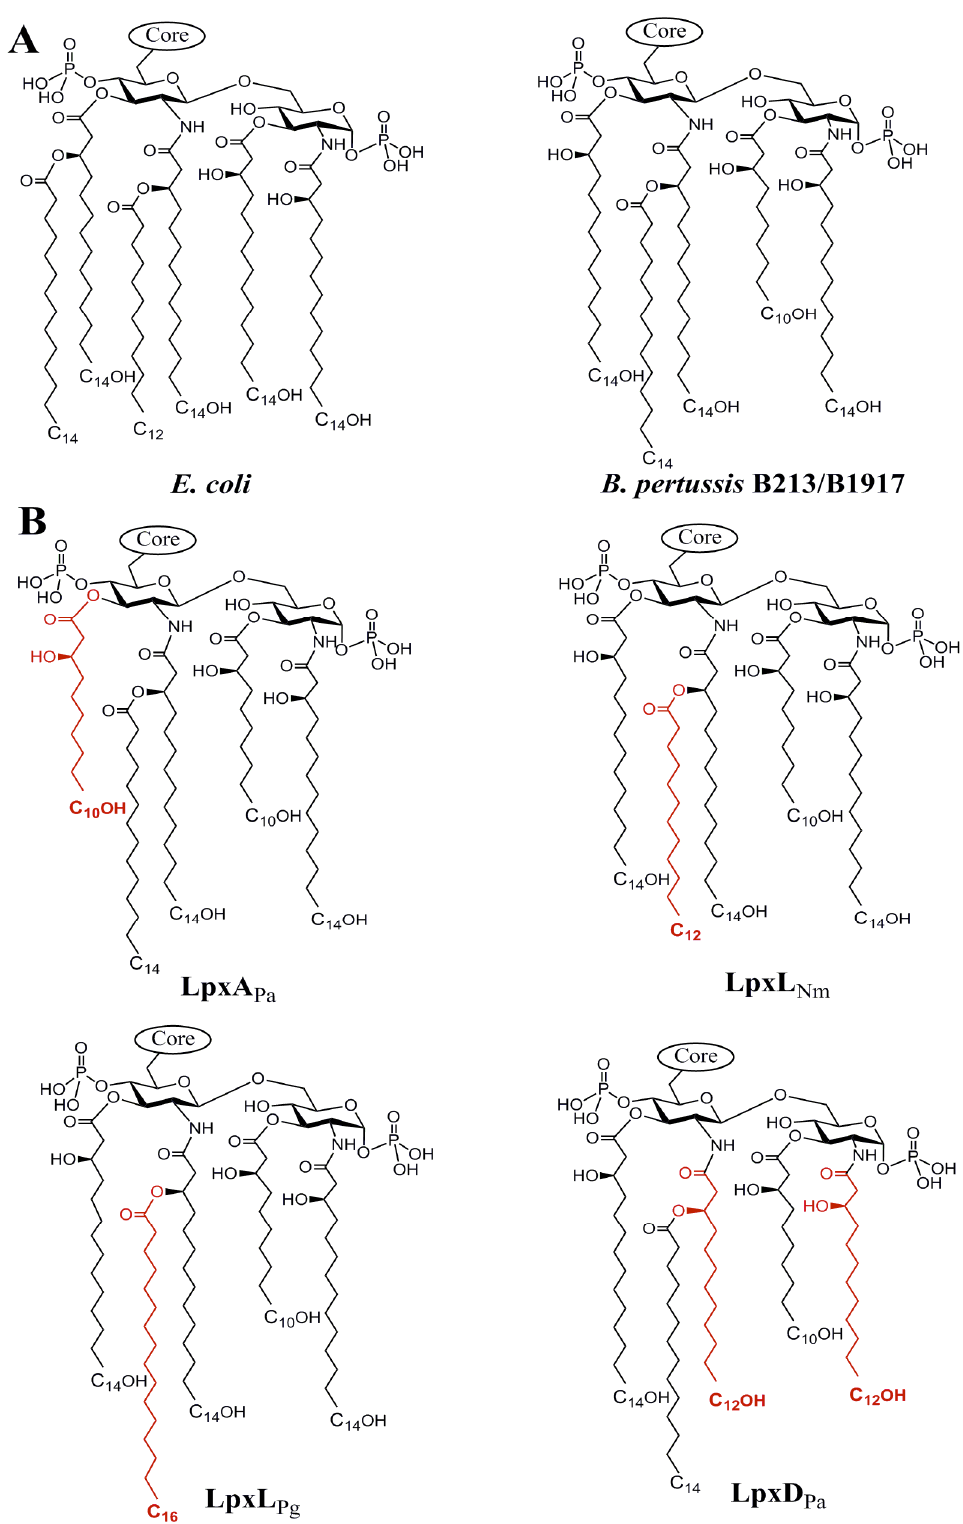
Figure 1. Lipid A structures of Escherichia coli and Bordetella pertussis ( A ) and those expected after replacing the acyltransferases in B. pertussis ( B ). The altered acyl chains that are introduced after replacing the acyltransferases of the wild type by the heterologous enzymes are shown in red. The heterologous enzymes expressed are indicated below the structures. Pa, Pseudomonas aeruginosa ; Nm, Neisseria meningitidis ; Pg, Porphyromonas gingivalis . 3OH-C14, 3OH-C12, and 3OH-C10 acyl chains are indicated as C14OH, C12OH, and C10OH, respectively.